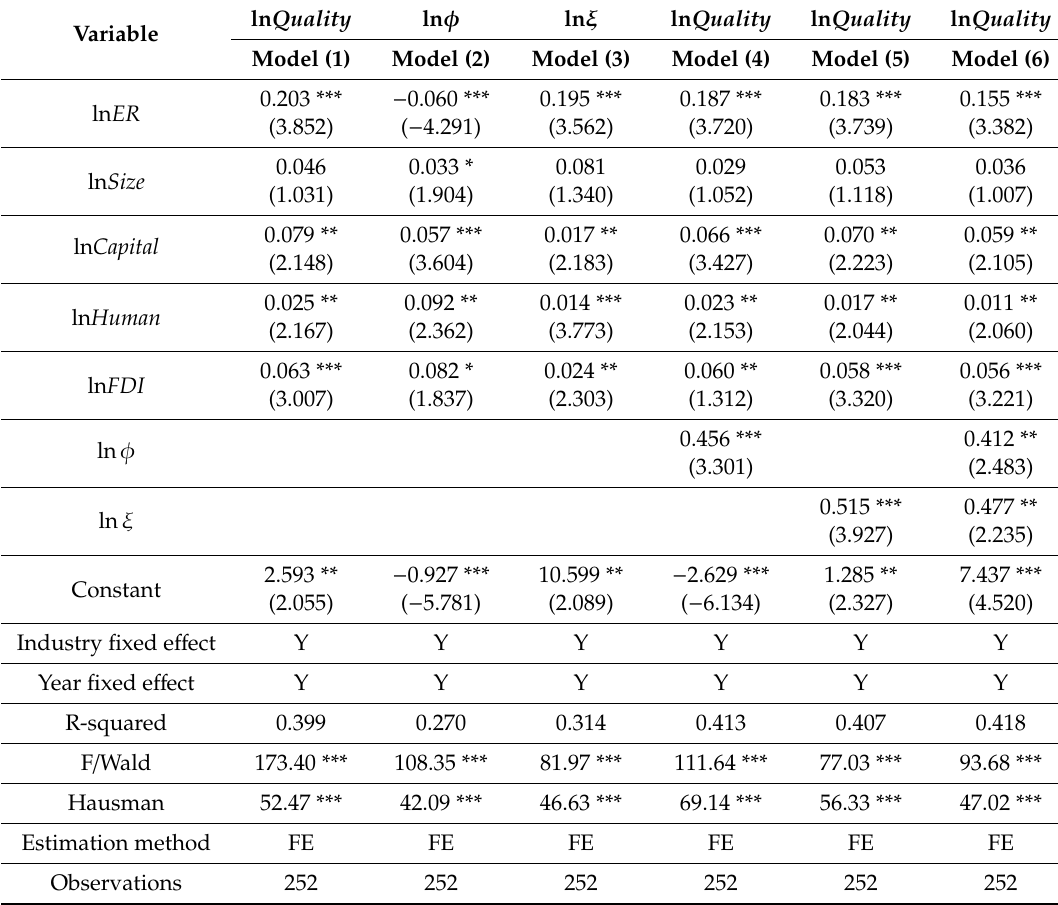
Table 6. Results of mediation